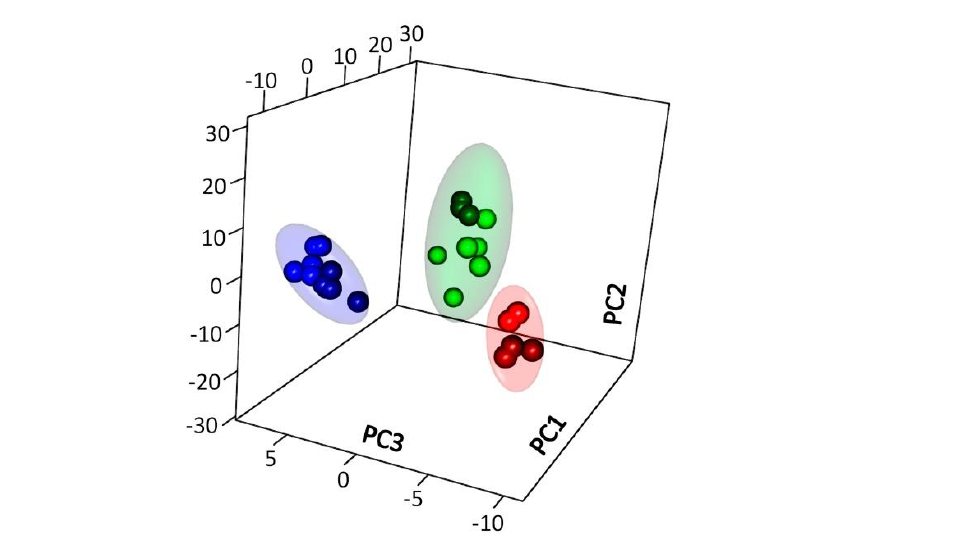
Figure 2. PCA score plot from principal component analysis of metabolite profiles of pea cv. Finale roots sampled at days 21 (in red), 42 (in green), 56 (in blue) infected with AM fungus R. irregularis (darker dots) or not (lighter dots). Ellipses are 90% CI.